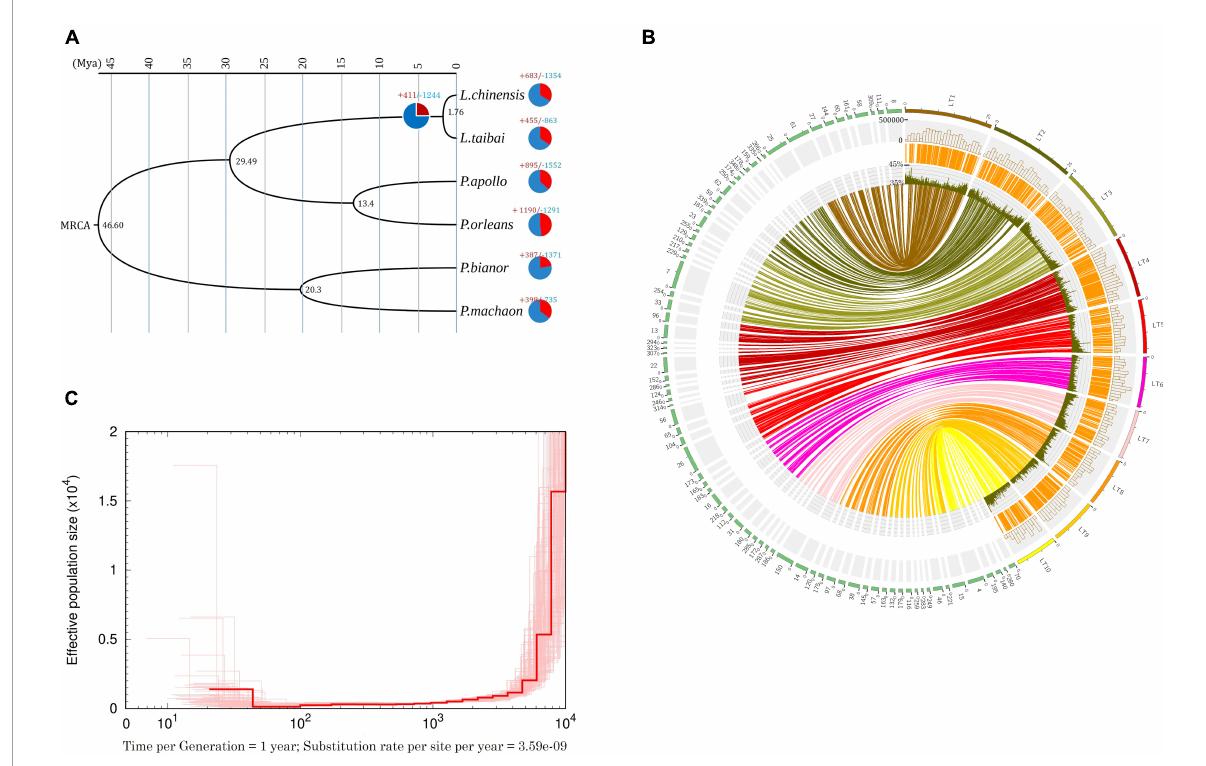
FIGURE1 (A) Time-calibrated phylogeny of the six butterfly species based on single-copy orthologous genes. Numbers on the pie charts indicate the numbers of gene families that experienced expansion (red) or contractions (blue); the number beside each node denotes the estimated divergence time (million years ago). (B) Circos plot of syntenic blocks between L. taibai (longer colorful blocks on the right) and L. chinensis (shorter green blocks on the left) genome. Only the longest ten contigs in L. taibai are shown. The internal lines link the collinear gene pairs, and the outer circles (from inside outward) represent GC content (sliding window of 1 Mb), expressed gene location, and SNP density (sliding window of 1 Mb). The outermost numbers and strings represent the names of the contigs for L. taibai and the scaffold number for L. chinensis . (C) Estimated historical effective population size (Ne) of L. taibai with bootstrap results (thin